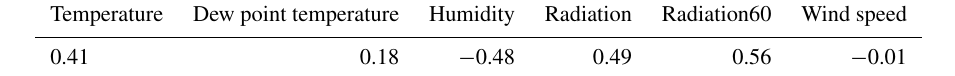
Table 7. The Pearson correlation matrix of temperature bias with other meteorological variables measured by the low-cost station.